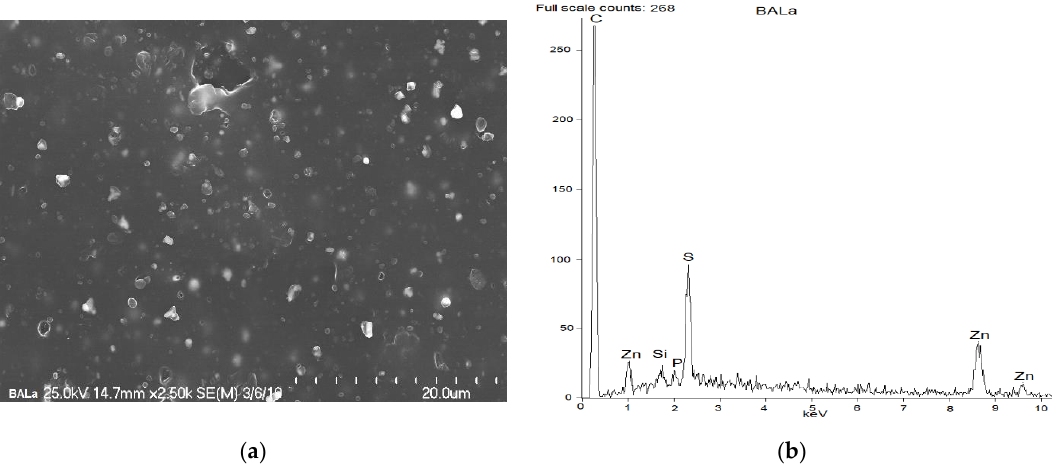
Figure 20. Dispersion of curatives in EPDM vulcanizate containing BALa: ( a ) SEM image; ( b ) EDS analysis.